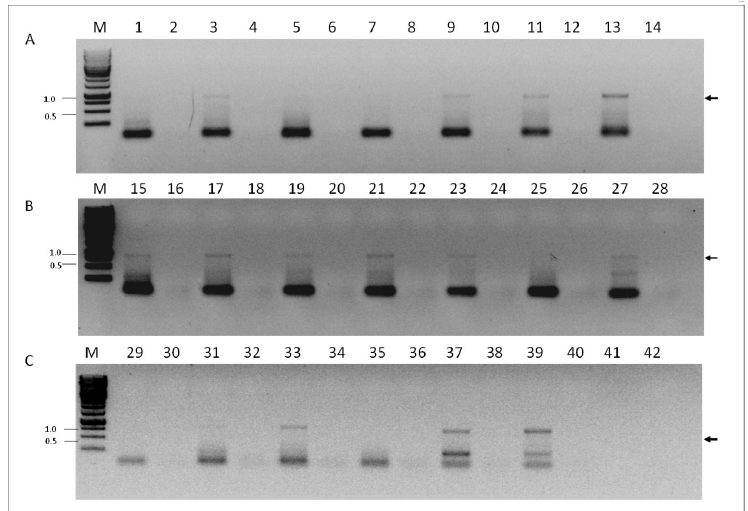
Figure 4. Detection of the VOV-1-segment 6 positive-sense RNA strand in V. destructor and A. mellifera. ( A ) V. destructor individuals, odd sample numbers and their respective controls, even sample numbers. ( B ) V. destructor (pools) odd samples, and their respective controls, even samples. ( C ) Lanes 29